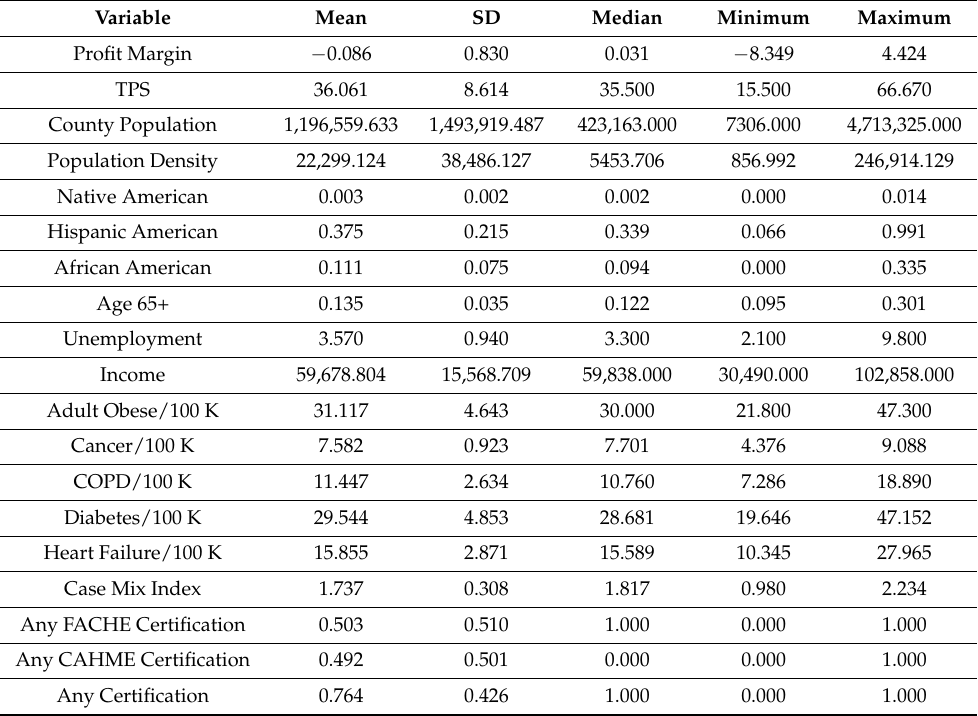
Table 2. Descriptive statistics and quantitative